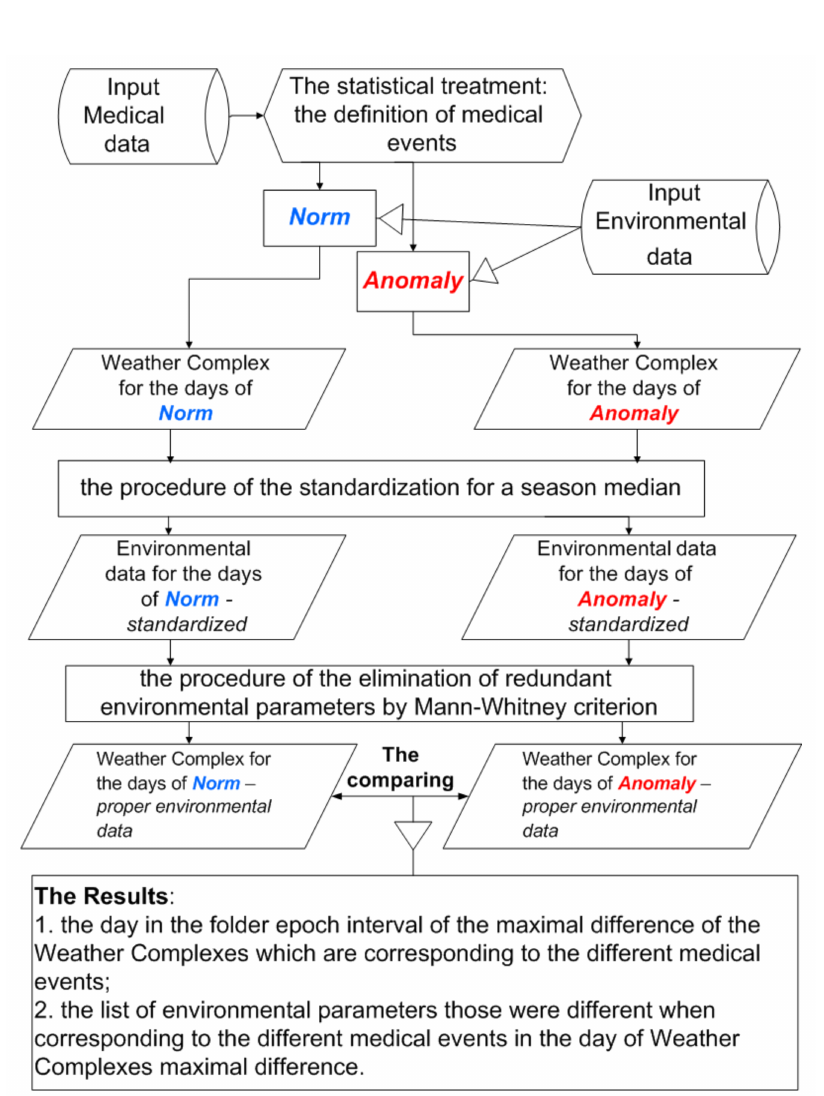
Figure 2. The scheme of the method. The term “Norm’ (blue color) means the normal (Middle in this work) number of ischemia cases, the term “Anomaly” (red color) means the absence of such cases (Nobody” in this work). Terms were explained above in Section